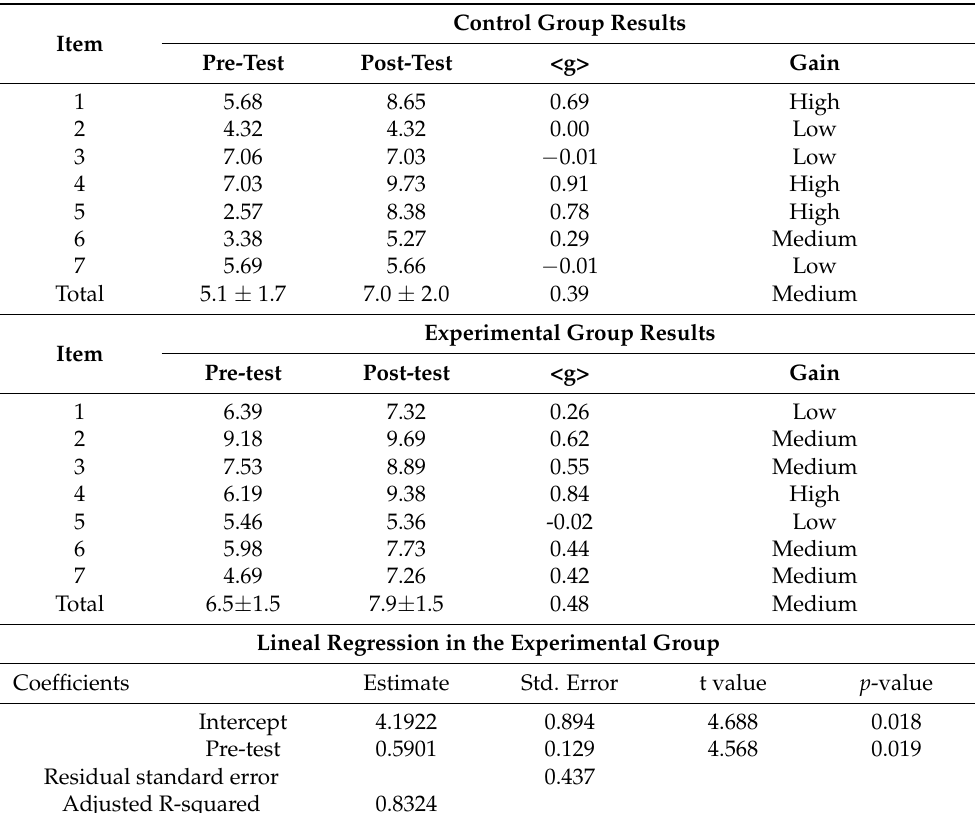
Table 5. Categorization, score (over 10 points), and gains obtained from the different items of the pre- and post-test questionnaires for both groups. Only significant linear regression was obtained for the experimental